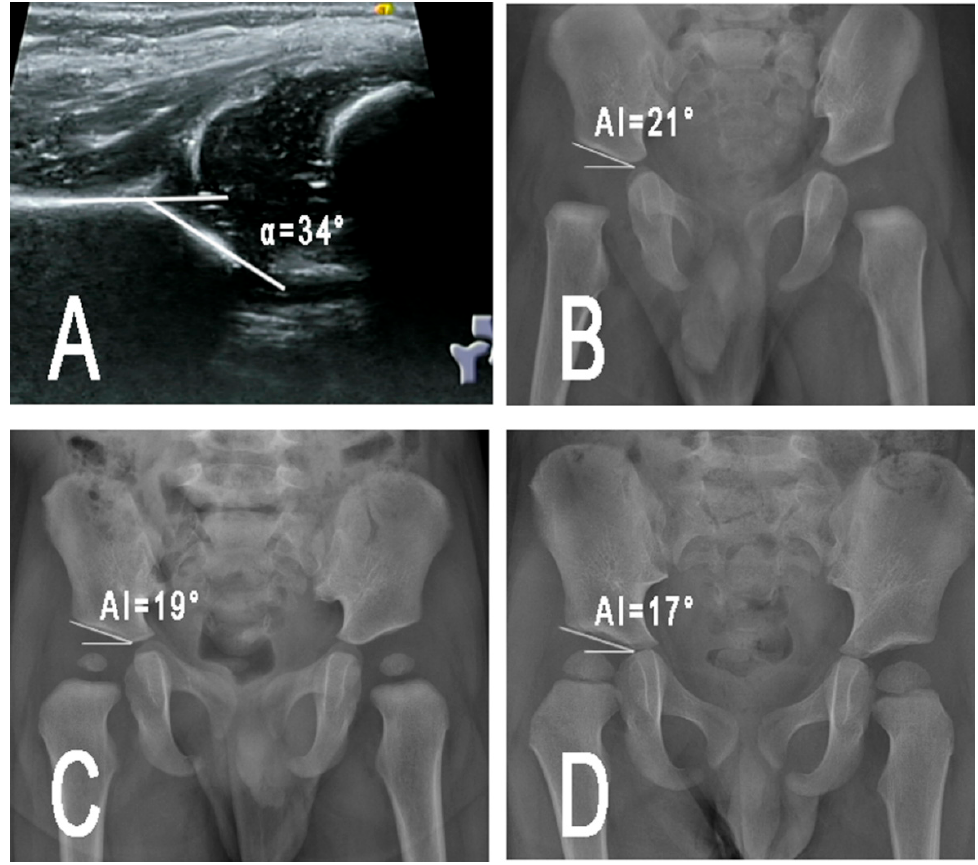
Figure 2. A patient aged 4 months with right DDH (Graf type III) ( A ), treated by PH for 4 months and recovered to normal radiograph ( B ). Six months later, radiographic examination showed good development of the hip ( C ). At final follow-up (2 years old), the outcome is satisfactory ( D ).